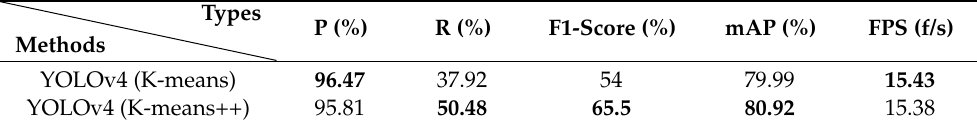
Table 1. Comparison of K-means++ and K-means algorithms.